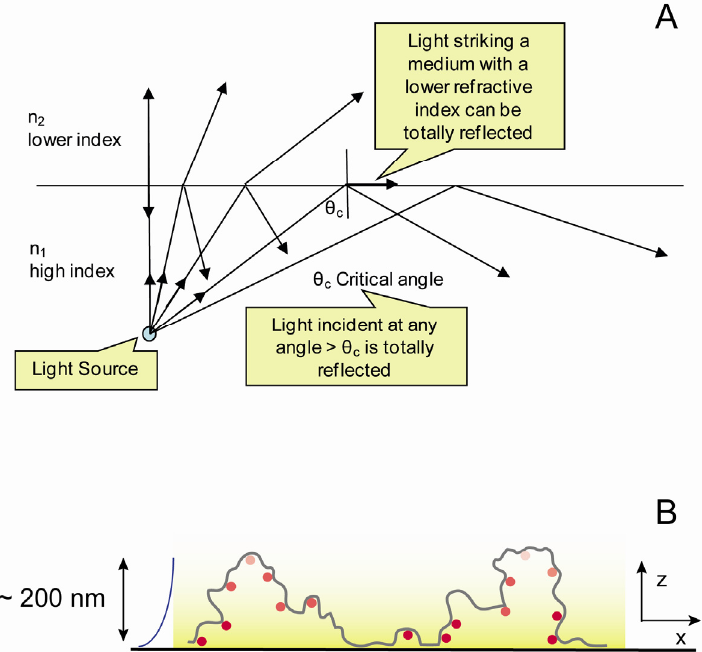
Figure 3. ( A ) Illustration of the principle of Total Internal Reflection Fluorescence (TIRF) microscopy. ( B ) Effect of TIRF illumination on fluorescent molecules in the plasma membrane of adherent cells; molecules close to the cover slip receive more intense illumination, and there is no illumination beyond a depth of approximately 200